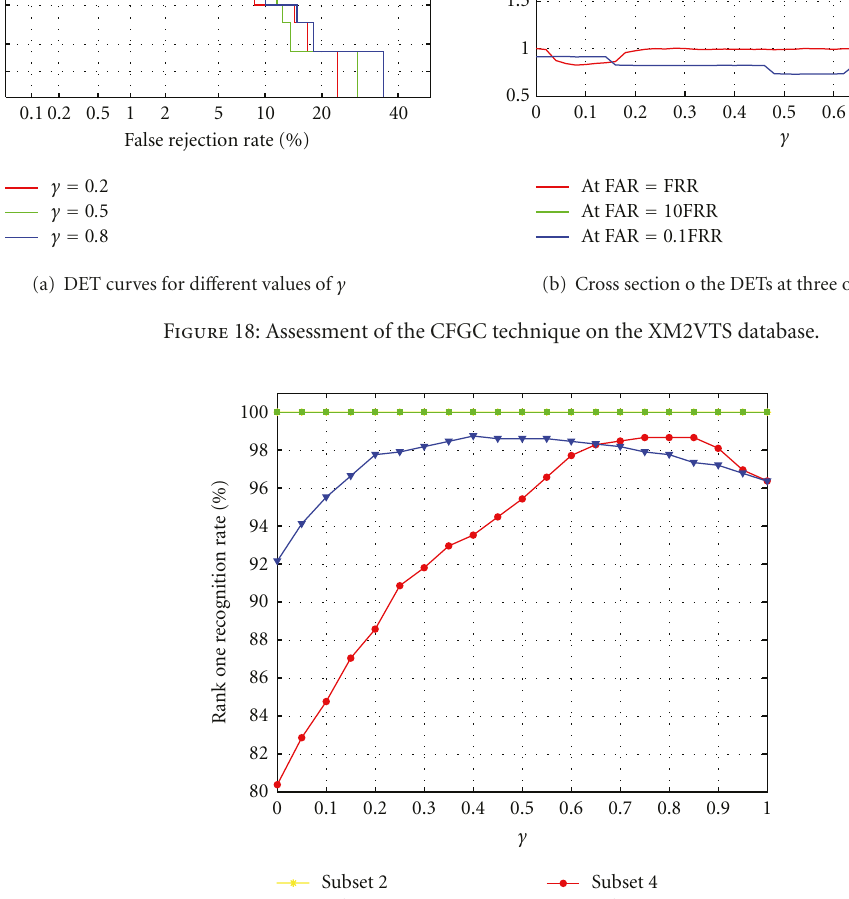
select a value of γ = 0 . 7 for the calculation of the